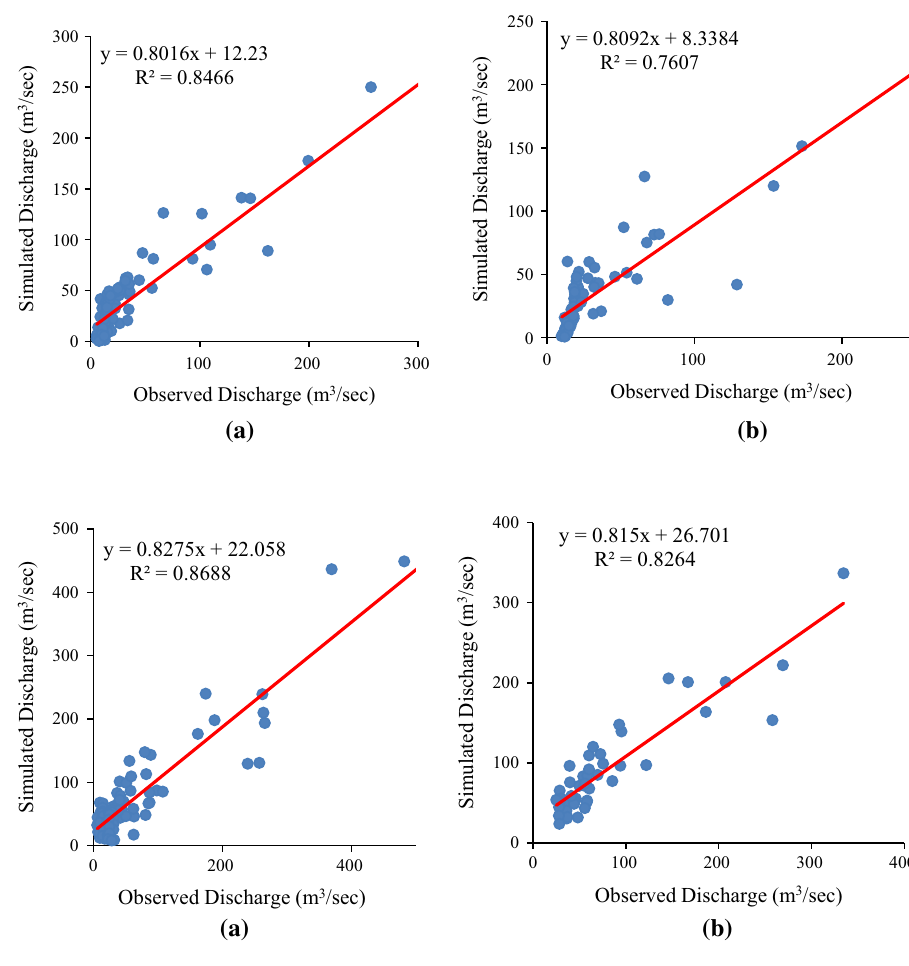
y = 0.8016x + 12.23 R² = 0.8466